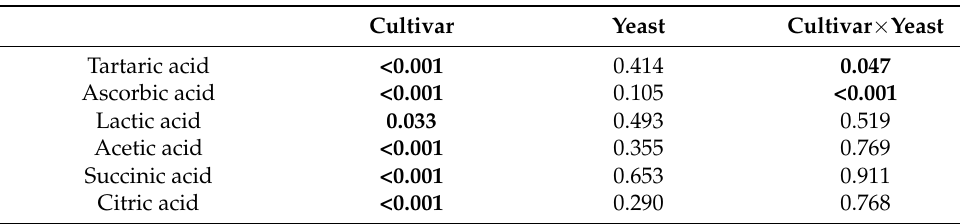
Table 3. Results of two-way analysis of variance on organic acids contents of pomegranate wines ( p -values